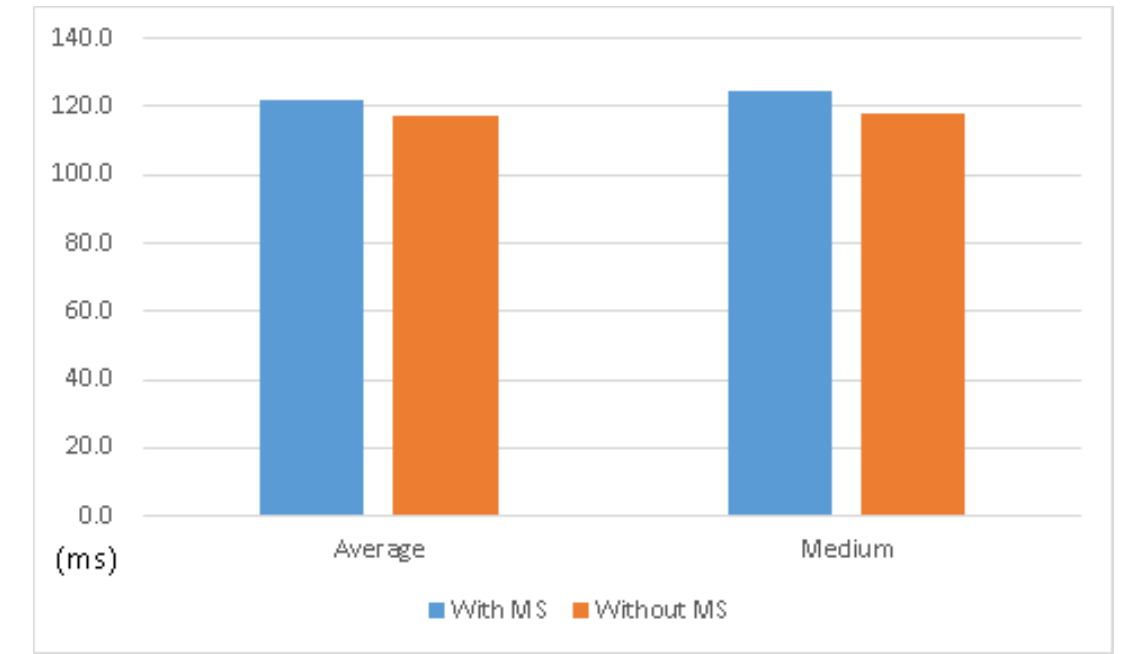
Figure 11. Average time and medium time of testing existing functionality — download data.